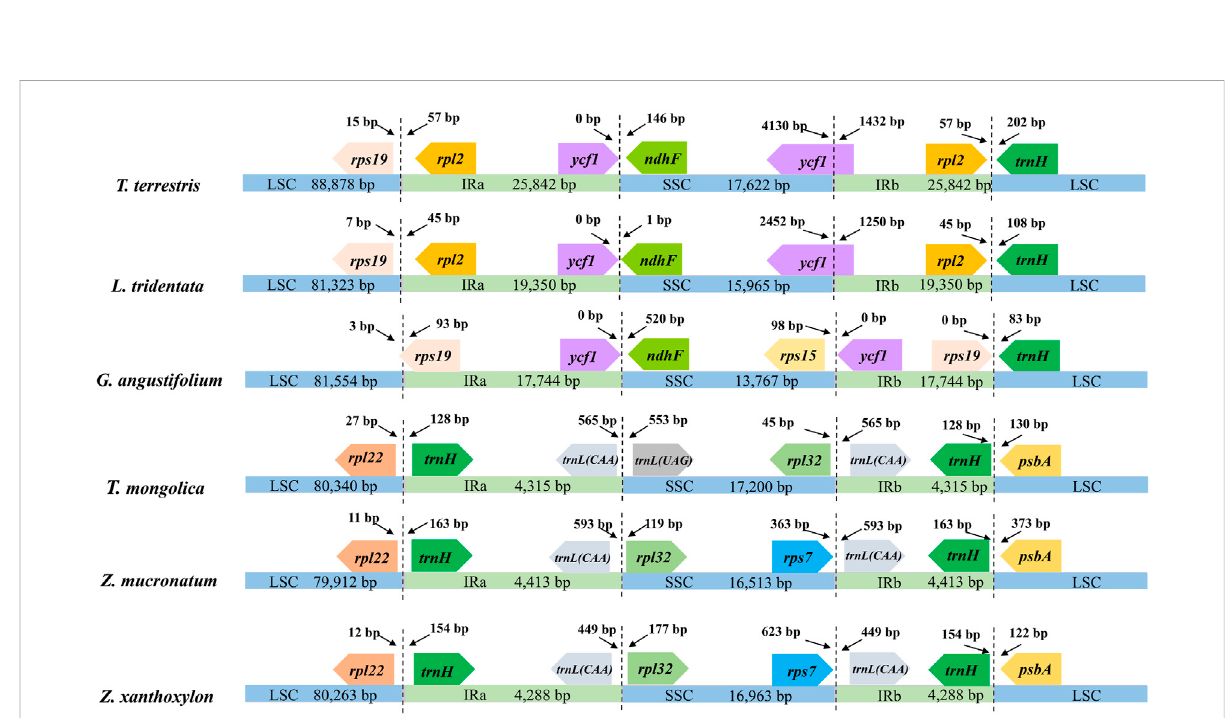
FIGURE 3 IR/SCboundariesofsixZygophyllaceaechloroplastgenomes.Numberabovethegenefeaturesmeansthedistancebetweentheendsofgenes and the borders sites. These features are not to